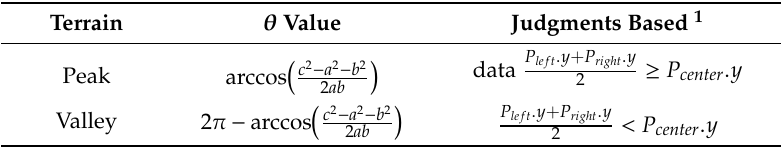
Table 1. Calculation method of mountain and valley.